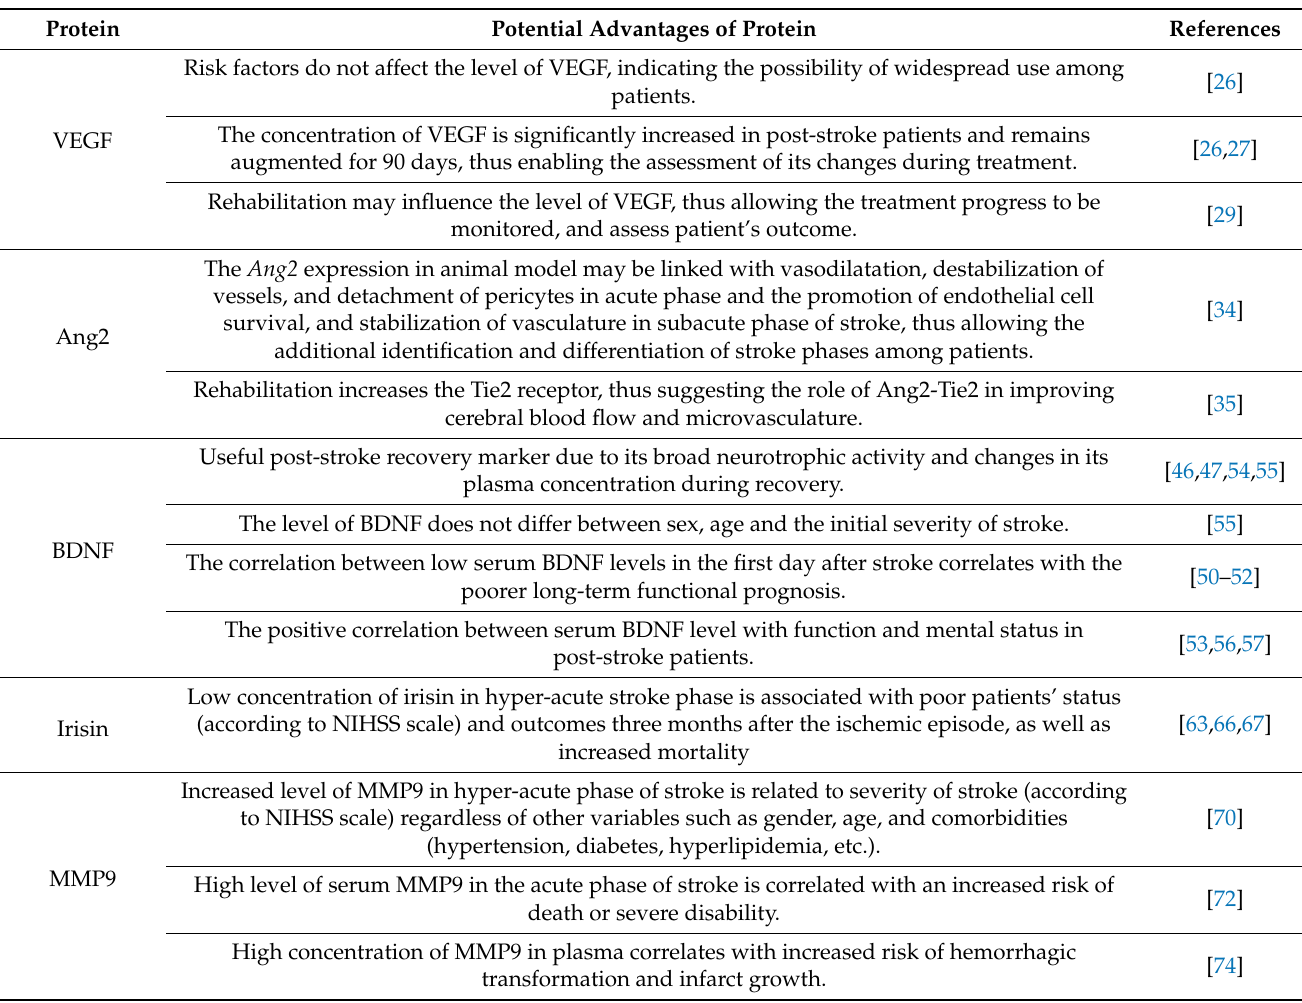
Table 1. Features of selected, potential biomarkers of post-stroke regeneration. VEGF—vascular endothelial growth factor; Ang2—angiopoietin 2; BDNF—brain-derived neurotrophic factor; MMP9—matrix metalloproteinase 9. Protein Potential Advantages of Protein